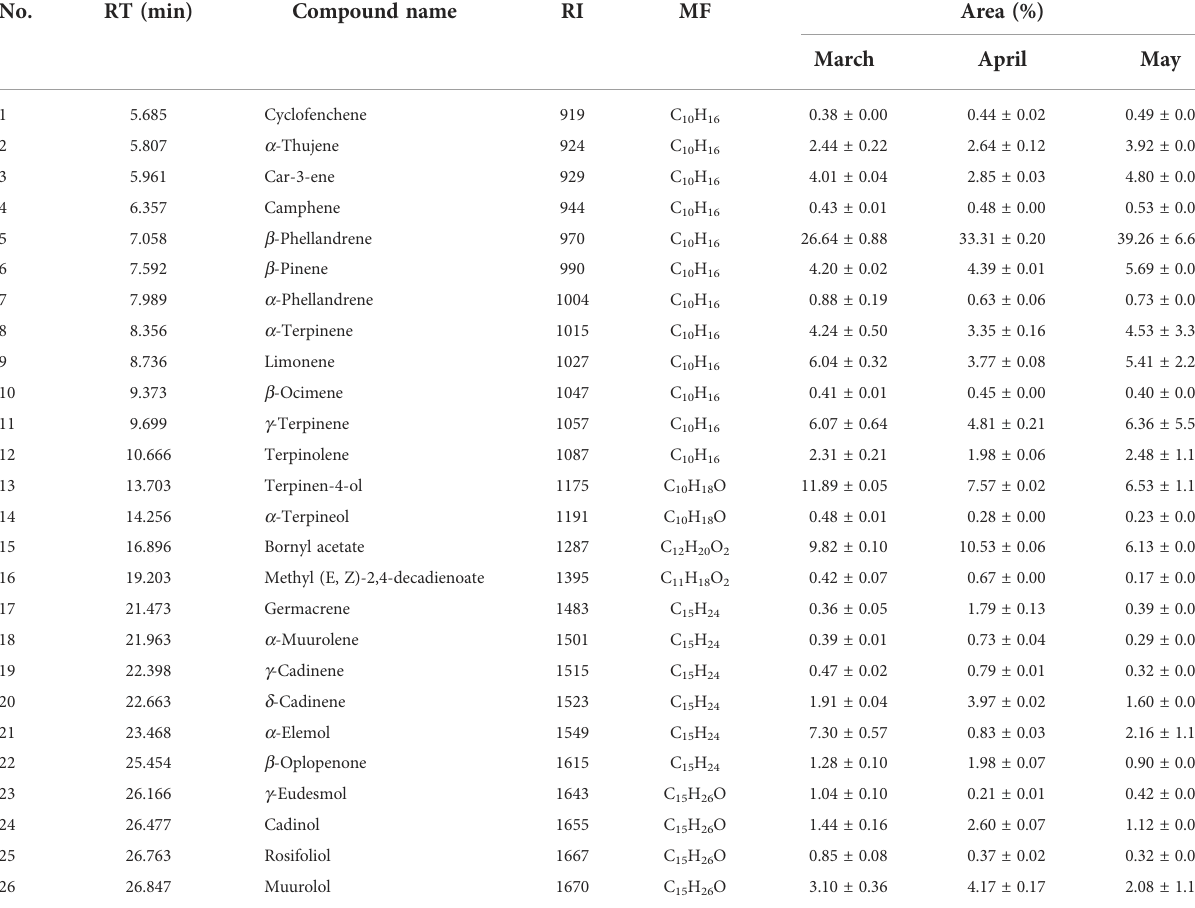
TABLE 2 Chemical compounds of the essential oils of Sabina chinensis .